Question: Express in one sentence what the figure is showing.
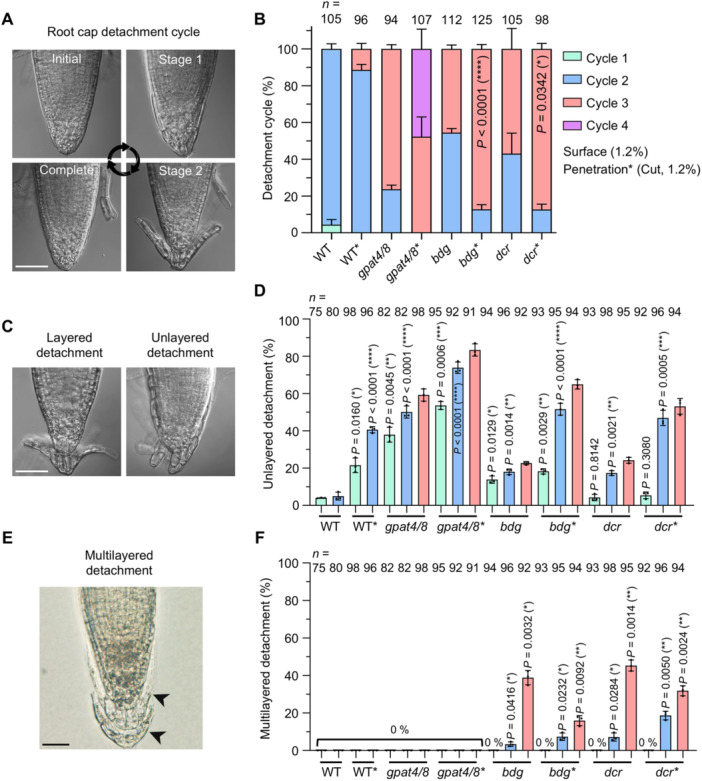
Answer: Effects of penetration and the root cap cuticle on the root cap detachment. (A) Representative images of the initial state, stage 1, stage 2, and complete detachment during the root cap detachment cycle. (B) Quantification of the root cap detachment cycle in 5‐ and 6‐DAG seedlings of WT, gpat4 gpat8 ( gpat4/8 ), bdg , and dcr grown on 1.2% agar under either surface or cut‐penetration conditions. For the cut‐penetration condition, only seedlings that successfully penetrated the agar surface were analysed ( n > 93 roots). (C, D) Representative images of layered and unlayered detachment (C) and quantification of these detachment patterns in 3‐ to 6‐DAG seedlings of different genotypes grown on 1.2% agar under surface or cut‐penetration conditions (D) ( n > 74 roots). (E, F) Representative images of multilayered and unlayered detachment (E) and quantification of these detachment patterns in 3‐ to 6‐DAG seedlings of different genotypes grown on 1.2% agar under surface or cut‐penetration conditions (F) ( n > 74 roots). Quantification of the root cap detachment cycle was performed using independent experimental sets, whereas unlayered, layered, and multilayered detachment were quantified within the same experimental groups. All experiments were repeated at least three times: scale bars, 50 μm (A, C, E). Statistical analyses were performed using unpaired t tests with Welch's correction (B, D, F). In (B), surface‐grown and penetration‐grown conditions were compared. In (D), each mutant was compared with WT seedlings at the same growth cycle. In (F), each genotype was compared with the corresponding cycle 1 condition. Data are presented as the mean + SD (B) and mean ± SD (D, E). [Color figure can be viewed at wileyonlinelibrary.com ]